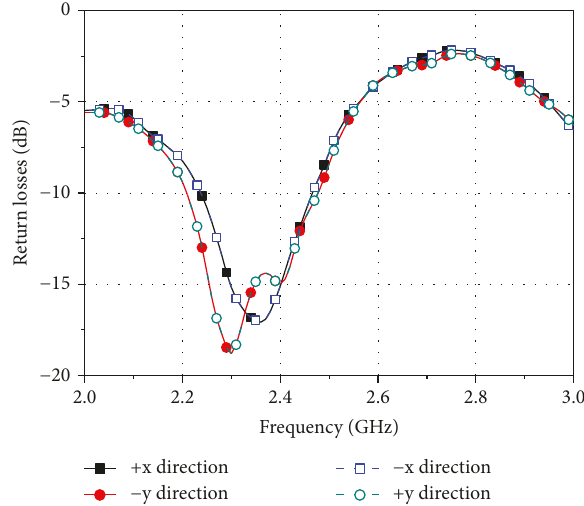
Figure 11: Return losses of the proposed antenna system for each beam